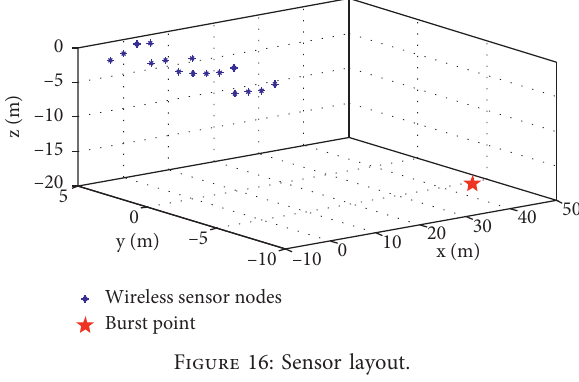
Figure 16: Sensor layout.